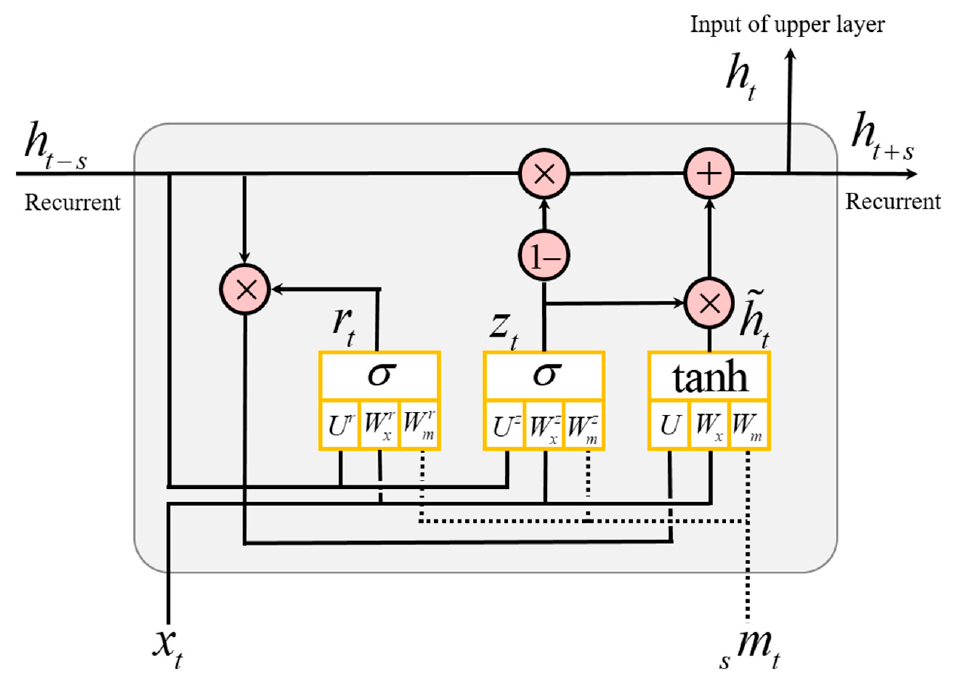
Figure 4. Our proposed enhanced gated recurrent unit (GRU) cell. The new components are displayed in dot-line. m is the feature vector of the multiscaled ( s ) signal at time t, and also, it is the same as the feature vector extracted from the last corresponding CNN layer by Equation (3). The output activation to the recurrent path is determined by the scaling factor s .